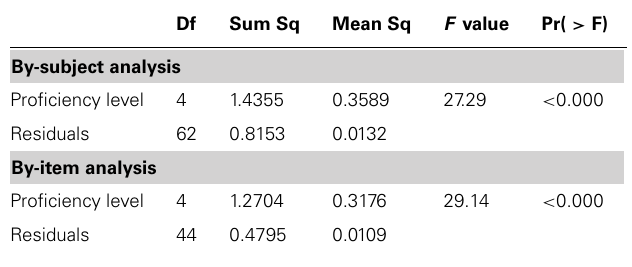
Procedure Table 5 | Repeated measuresANOVA results for Experiment 3: picture-word discrimination.